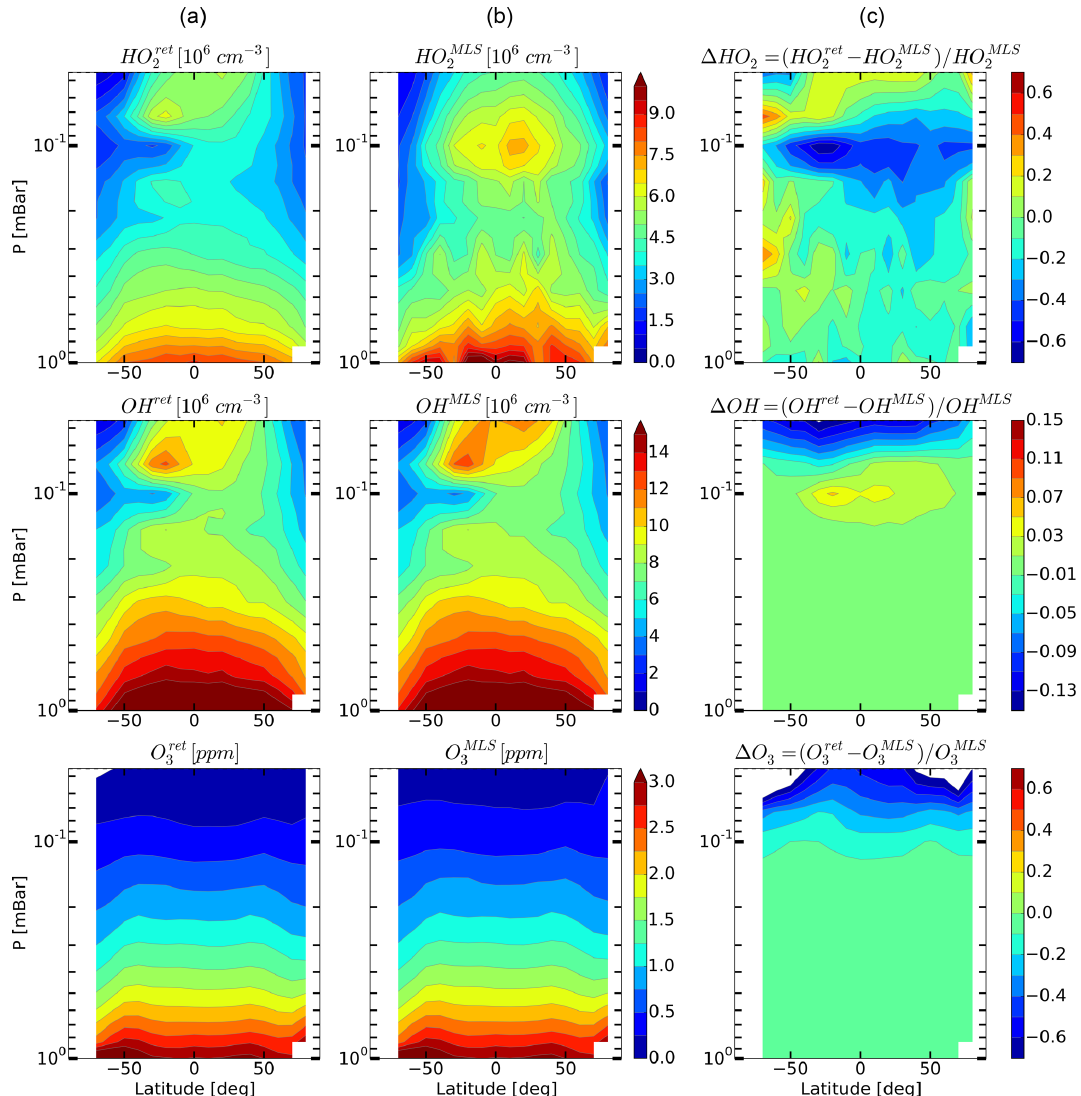
Figure 8. Daytime monthly averaged zonal mean retrieved (a) and measured (b) distributions of HO 2 , OH, and O 3 and their relative difference (c) for September